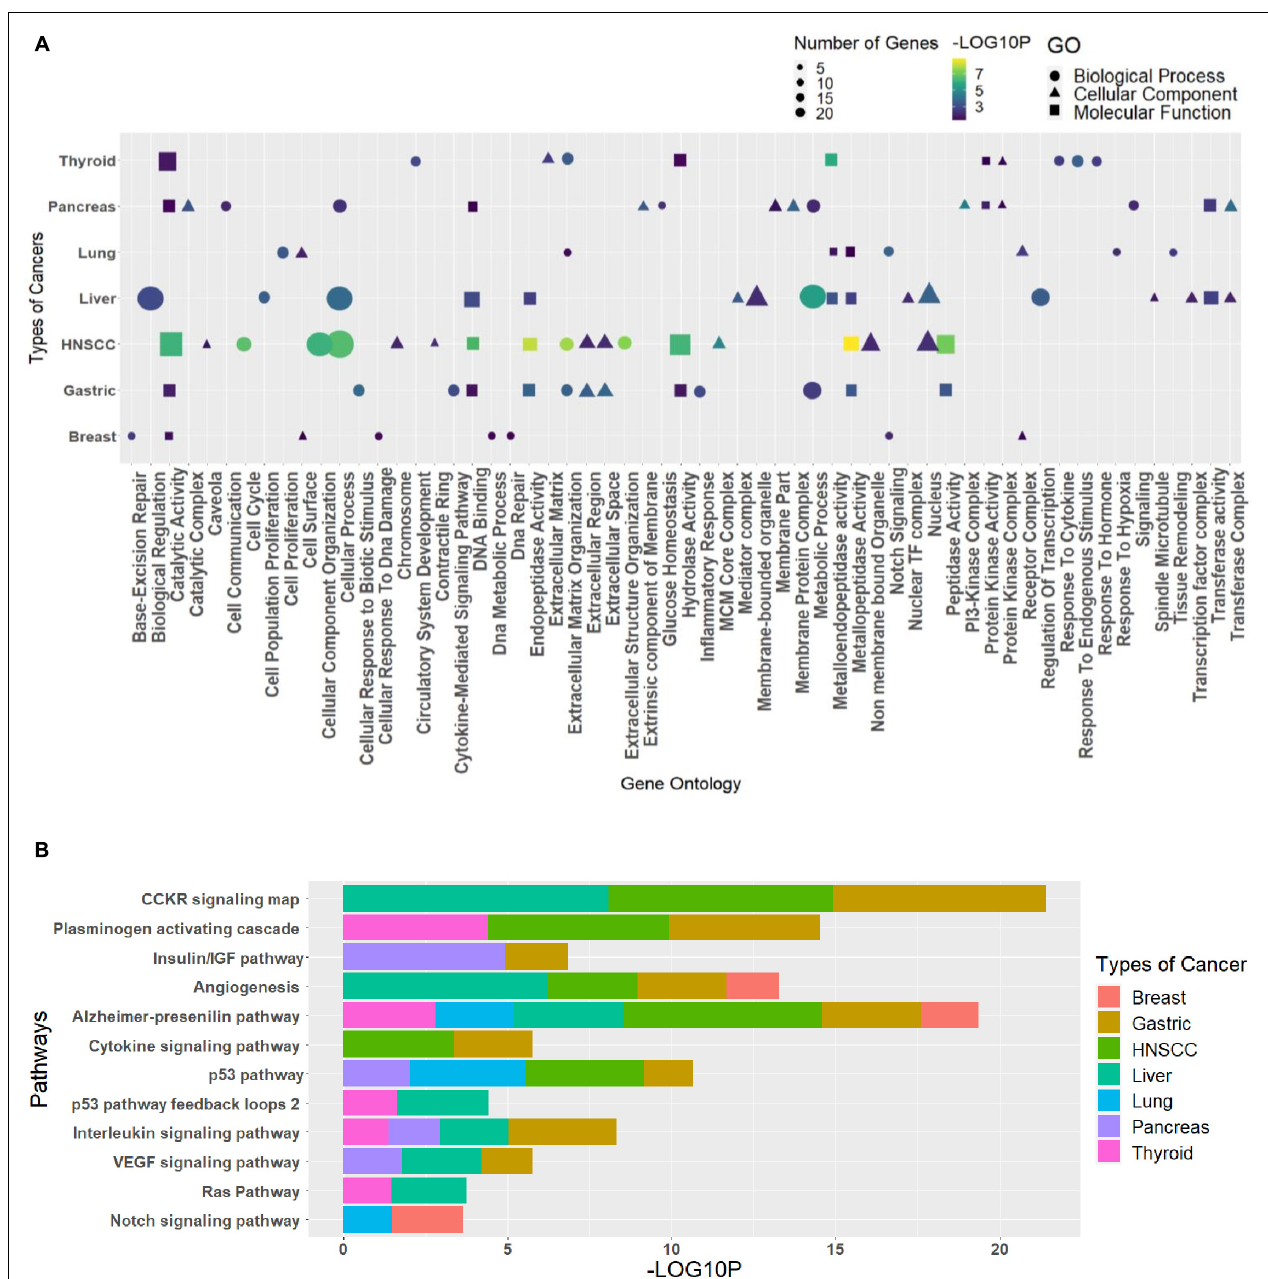
FIGURE 5 | The topmost common (A) gene ontologies and (B) pathways, taken from the largest cluster of each cancer. The graph has been plotted based on the significant p values ( p ≤ 0.05), taken as the negative logarithm of the p value (–log 10 p